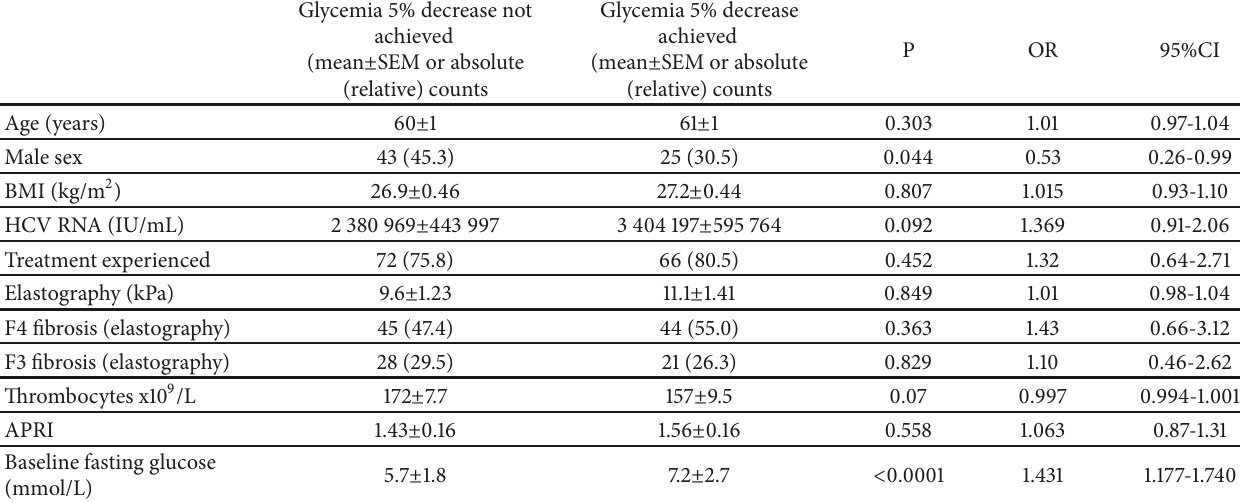
Table 6: Predictors of significant ( > 5%) decrease of glycemia after DAA